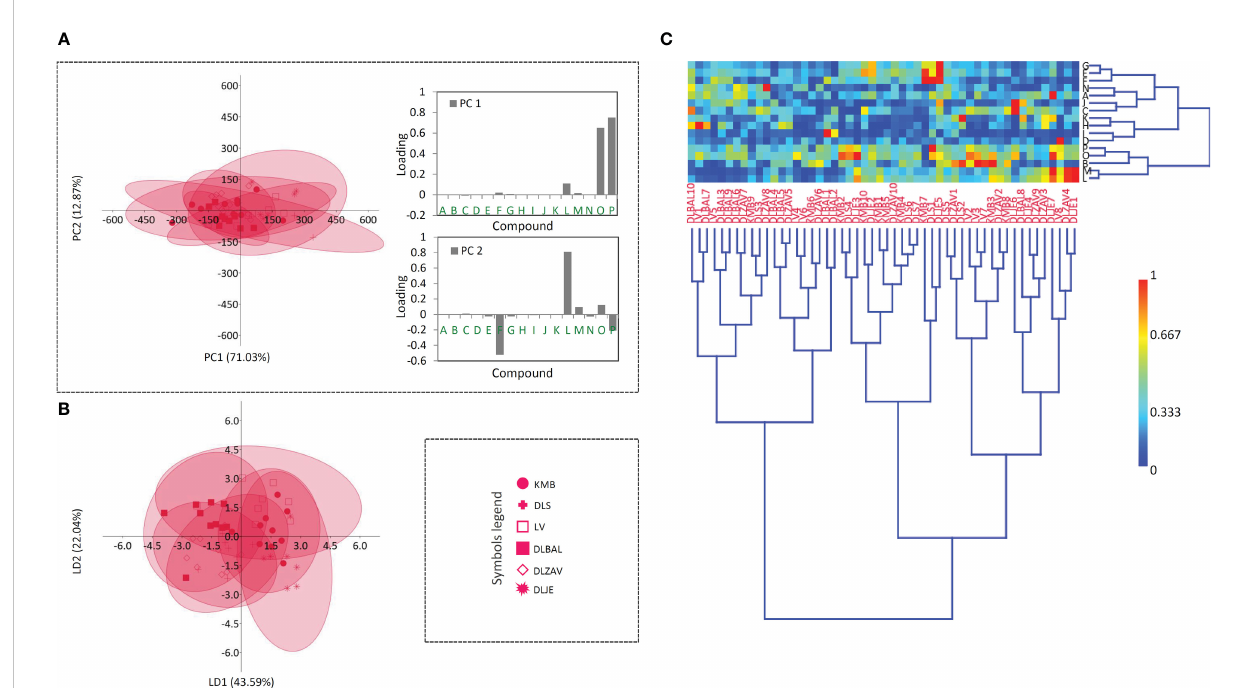
FIGURE 5 Principal component analysis (PCA) biplot with the fi rst two PCs explaining 83.90% of the total variance (A) among D. lanata accessions. For six D. lanata populations (each labeled by a different symbol) 95% con fi dence ellipses are presented. Participation of the variables (compounds) in the fi rst two PCs is indicated by the corresponding loading plots. Linear discriminant analysis (LDA) (B) represents the same six populations of D. lanata with 95% con fi dence ellipses. Heatmap of the scaled quantitative data (C) with the samples arranged according to the hierarchical cluster analysis (Ward ’ s method of cluster agglomeration). Compounds ’ labels are the same as in Figure 3. For the interpretation of population abbreviations in the fi gure legend, please refer to Table